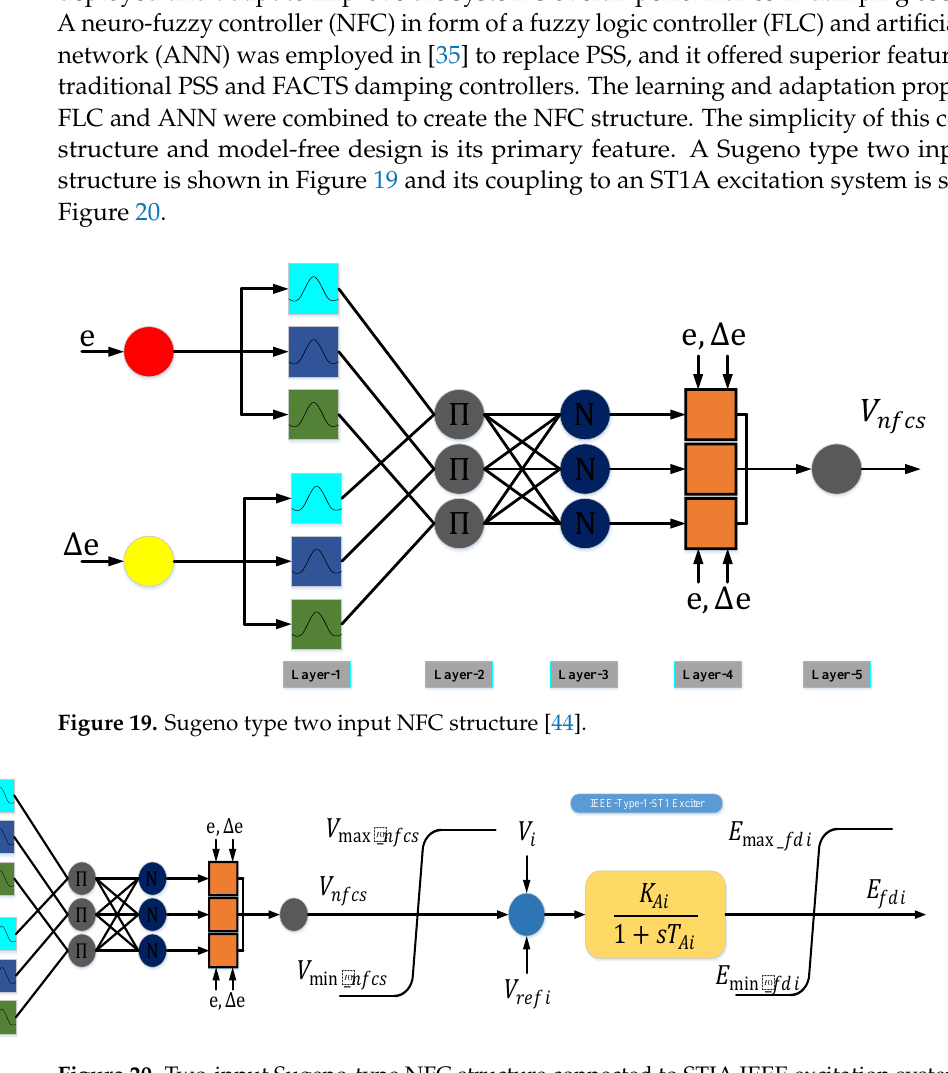
Figure 18. ( a ) SSSC, ( b ) STATCOM, ( c ) IPFC [44].